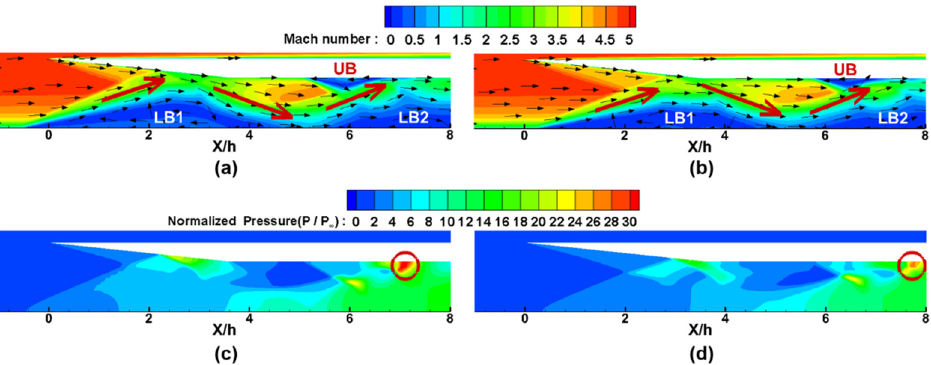
Figure 8. Comparison of the flow configurations of Patterns 1 and 2: ( a ) Mach number, velocity vectors at point [b] (Pattern 1); ( b ) Mach number, velocity vectors at point [ b (cid:2870) ] (Pattern 2); ( c ) nor- malized pressure at point [b] (Pattern 1); ( d ) normalized pressure at point [ b (cid:2870) ] (Pattern 2). After the impact on the lower wall, the supersonic flow bounces back to the upper wall again. As marked by solid red circles in Figure 8c,d, the bounced flow generates a local high-